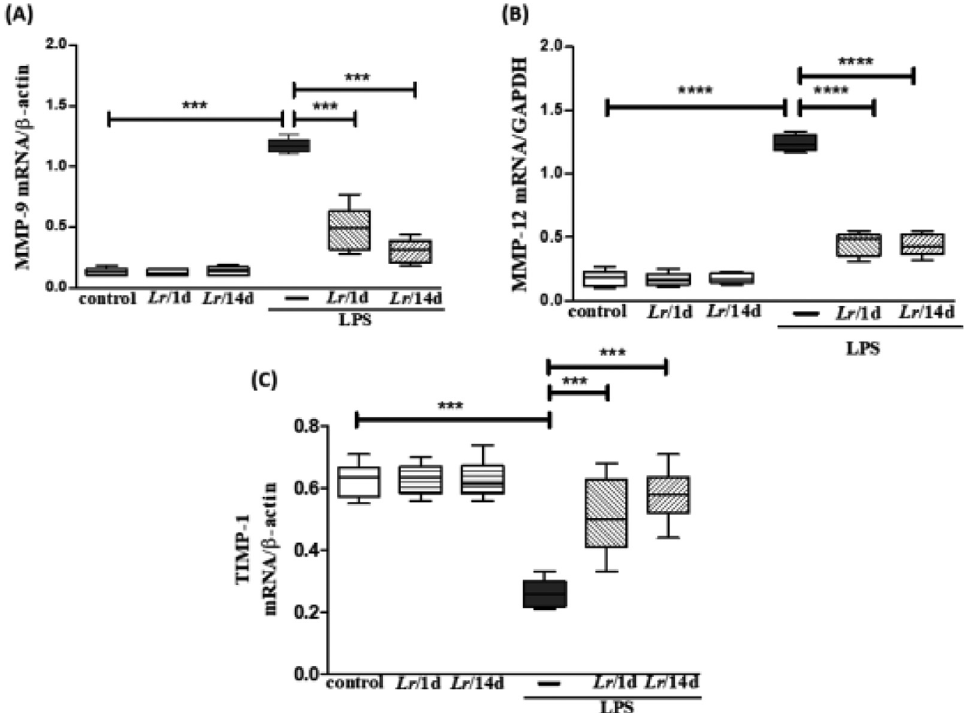
Fig. 6. Gene expression of MMP-9, MMP-12 and TIMP in lung tissue. The C57Bl/6 mice were treated with Lacticaseibacillus rhamnosus (10 9 CFU Lr in 300 µ L of PBS, orogastric by gavage) for 14 days or one day, before E. coli LPS instillation (0.5 mg/Kg, intranasal). The mice were euthanized 24h after the LPS, and the qPCR was processed according to Materials and Methods. MMP-9 (6A); MMP-12 (6B), and TIMP (6C). The results are expressed as mean ± SEM **** p < 0.0001; *** p < 0.001; ** p < 0.01; * p < 0.05 and ns: non-signi fi cant